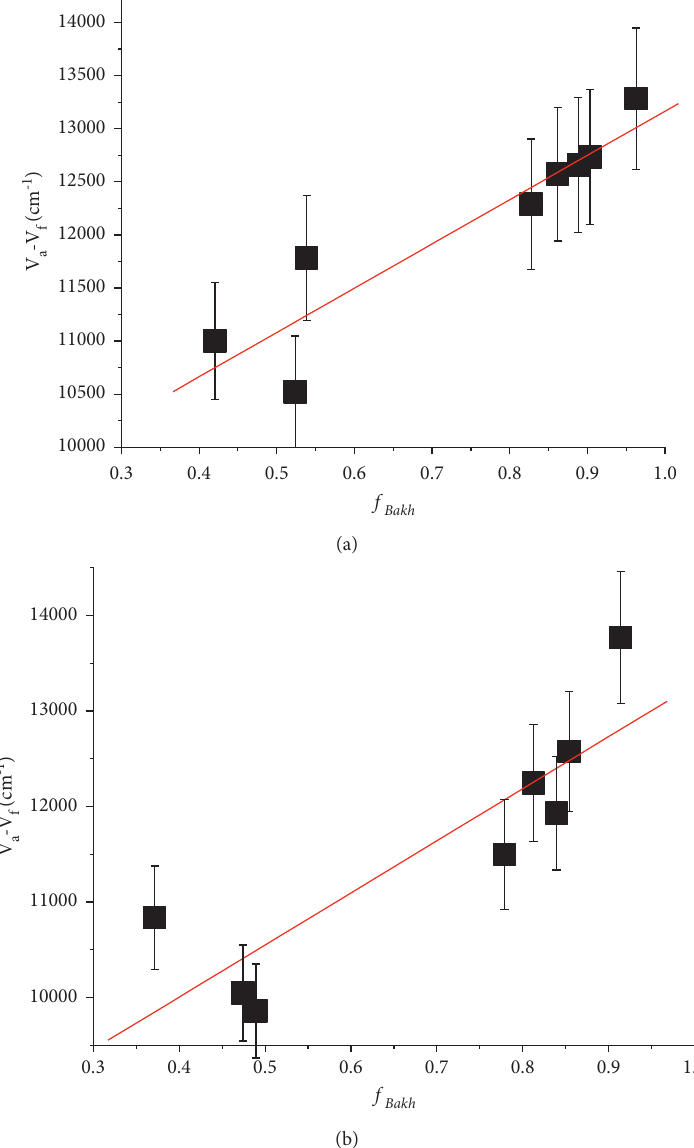
Figure 4: Plot of ] − ] f ( ε , n ) using Bakhshiev’s equation for (a) LVF in different solvents (chloroform, dichloromethane, a f versus isopropanol, ethanol, methanol, distilled water, ethyl acetate, and ethyl glycol) and (b) NRF in different solvents (chloroform, dichloromethane, isopropanol, ethanol, methanol, distilled water, ethyl acetate, and ethyl